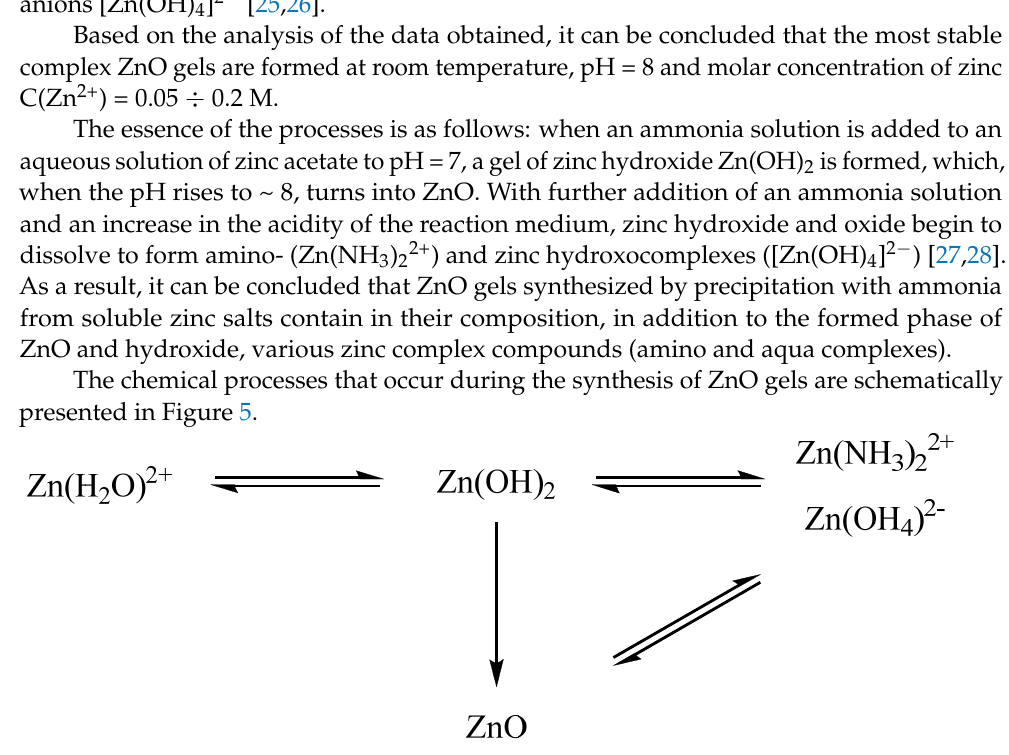
Figure 6. SEM micrographs of nanoscale ZnO stabilized with polysaccharides. Analysis of SEM micrographs of nanoscale ZnO showed that the samples of ZnO NPs gels consist of irregularly shaped aggregates. In the agar–agar stabilized sample, the aggregates have a lamellar shape. In turn, the surface of ZnO NPs stabilized with methyl- cellulose and hydroxyethylcellulose is represented by irregularly shaped particles that are